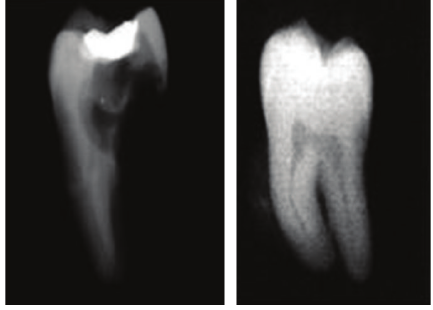
Figure 2: Extracted teeth 37,